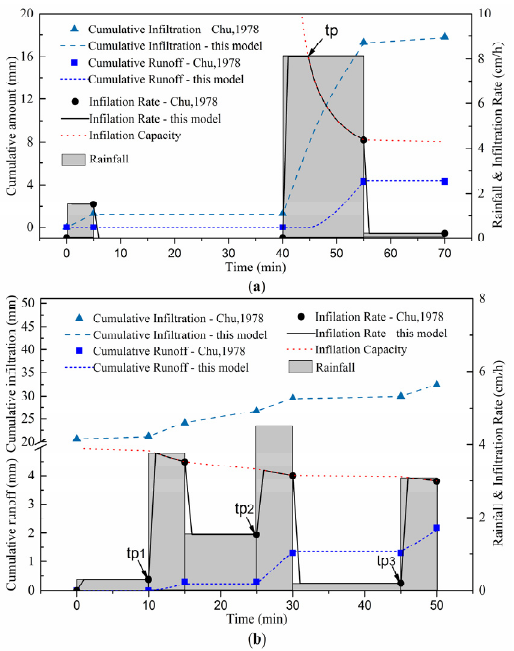
Figure 5. Homogeneous soil during unsteady rainfalls: ( a ) 30 June 1957; ( b ) 3 April 1958.